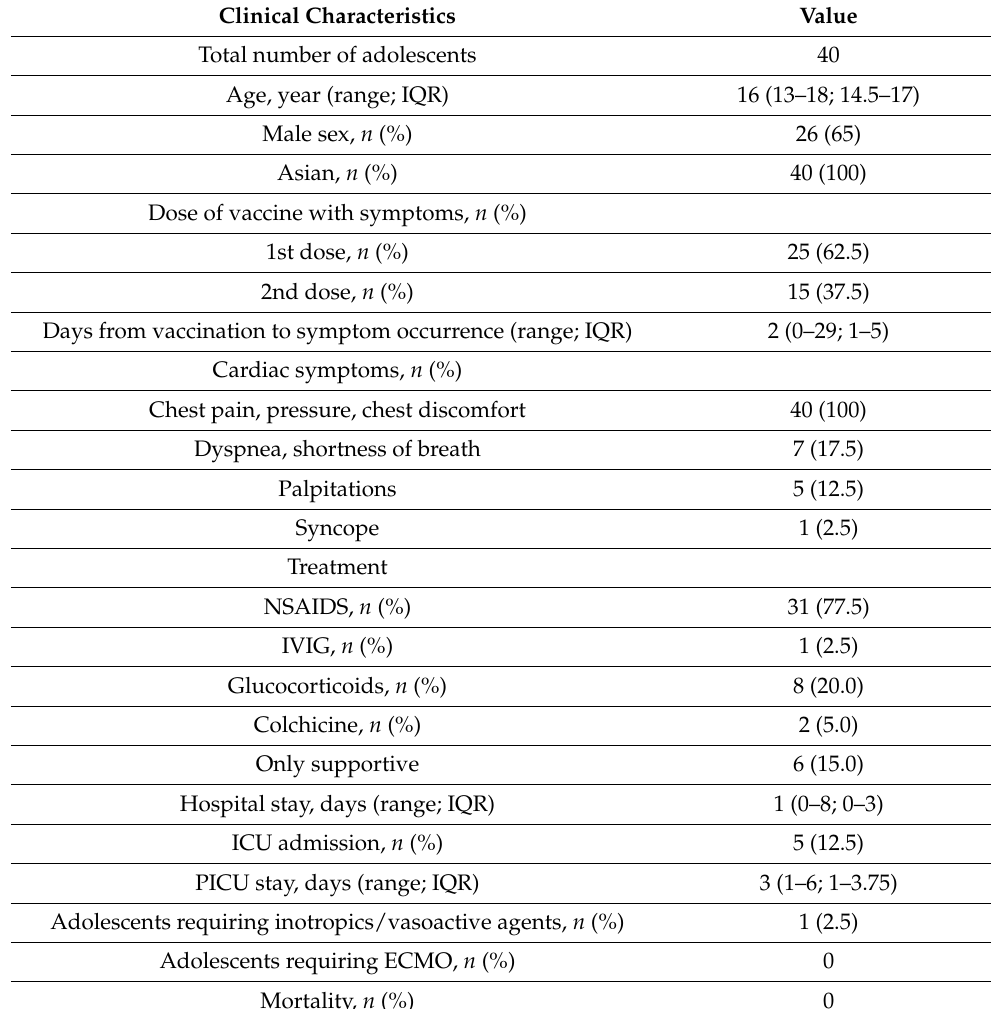
Table 1. Vaccination.